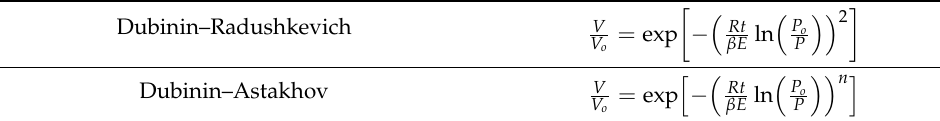
Table 3. Dubinin